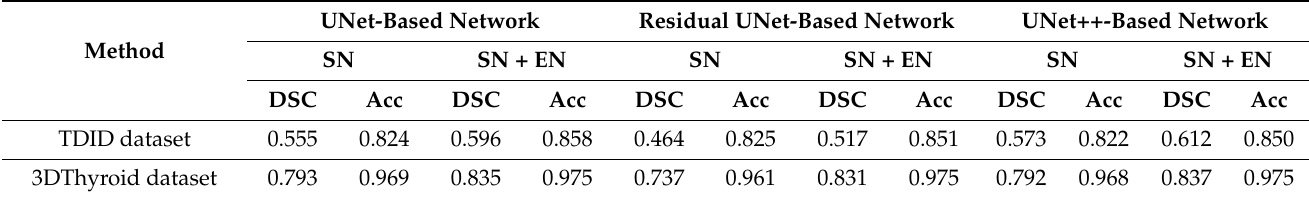
Table 6. Summary of segmentation performance with or without enhancement network on the TDID and 3DThyroid datasets.